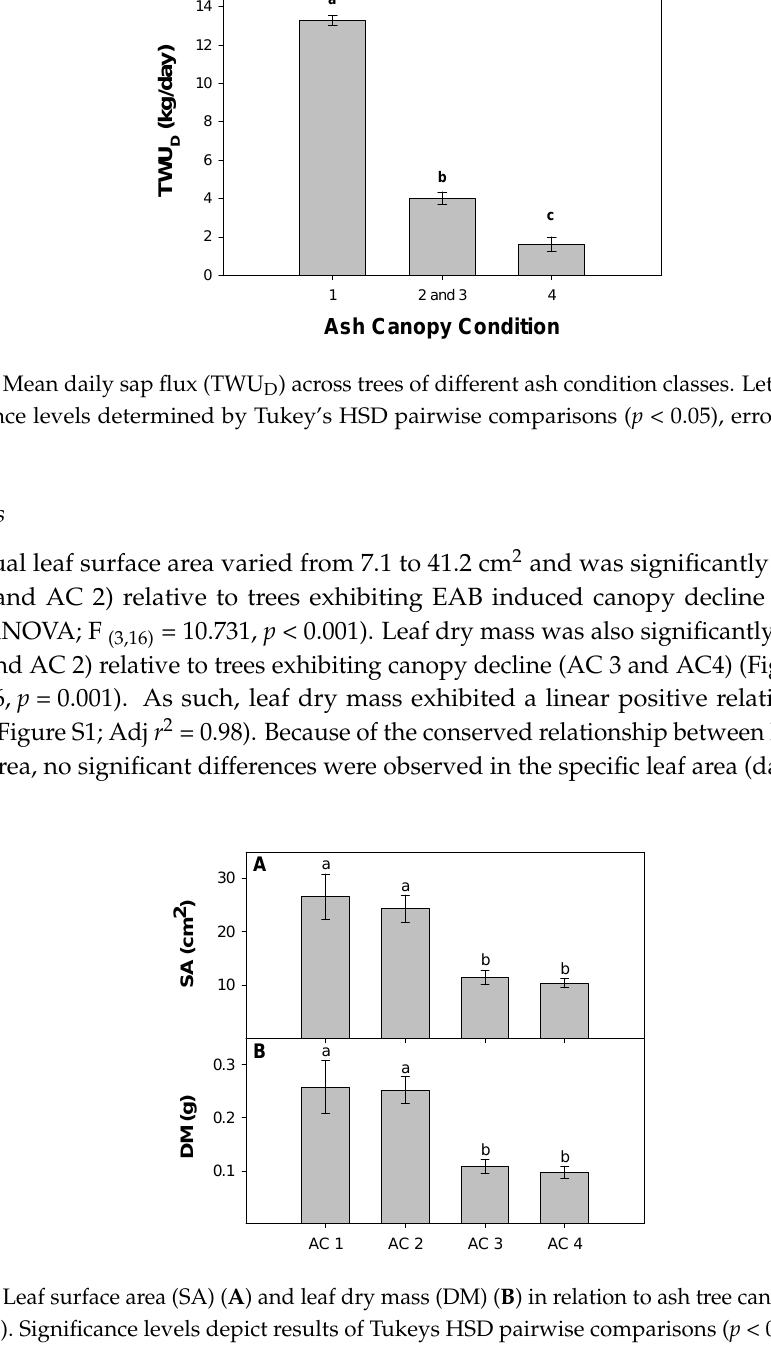
Figure 4. Leaf surface area (SA) ( A ) and leaf dry mass (DM) ( B ) in relation to ash tree canopy condition class (AC). Significance levels depict results of Tukeys HSD pairwise comparisons ( p < 0.05).